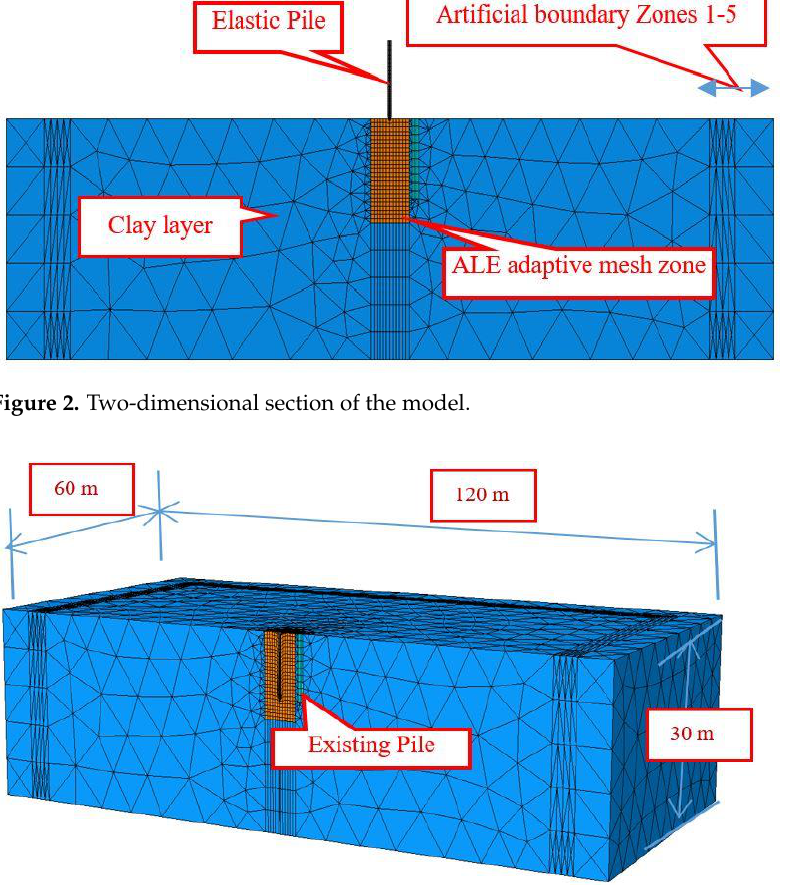
Figure 3. Three-dimensional model equivalent.